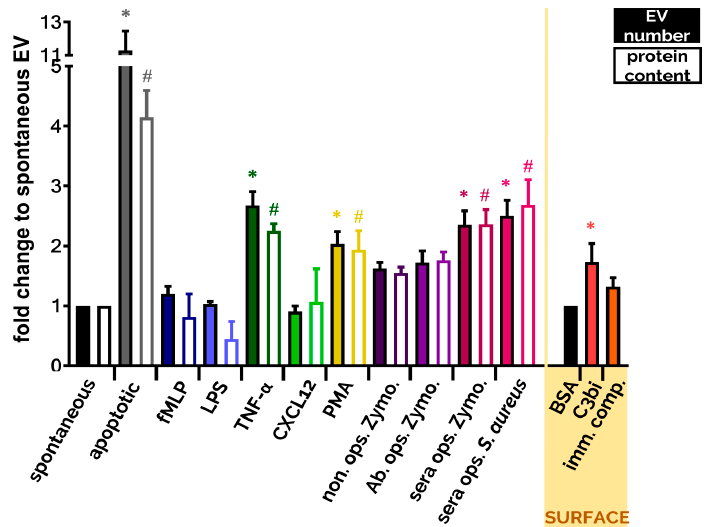
Figure 2. Comparison of EV production of PMNs after different soluble and surface-bound activators. EVs were analyzed immediately after isolation. Isolation and quantification of EVs is detailed in [10,124,140]. Filled bars represent the EV quantification by flow cytometry, empty bars represent the quantification based on protein amount measurement. Cells were treated with the indicated stimuli for 20 min at 37 °C. Stimuli were applied in a final concentration of 1 µM (fMLP), 100 ng/mL (LPS), 20 ng/mL (TNF- α ), 100 ng/mL (CXCL12), 100 nM (PMA), 5 µg/mL (Zymosan) or 108/mL S. aureus . Error bars represent mean + S.E.M. Data were compared by using one-way ANOVA coupled with Dunett’s post hoc test, n = 3 (fMLP, LPS, CXCL12, C3bi surface), 4 (apoptotic), 9 (TNF- α , immune complex surface), 12 bovine serum albumin (BSA), 22 (non ops. Zymosan, Ab. ops. Zymo., sera ops. Zymo.), 32 (sera ops. S. aureus ), 40 (sEV, PMA). On the “SURFACE” panel we show the FC quantification of EV production of adherent PMN on BSA surface (20 µg/mL), on C3bi surface (50 µg/mL) or on immune complex surface (imm. comp., 20 µg/mL). Error bars represent mean + S.E.M. Data were also compared by using one-way ANOVA coupled with Dunett’s post hoc test. Level of significance ( p < 0.05) is indicated by * for EV numbers and by # for protein amount.